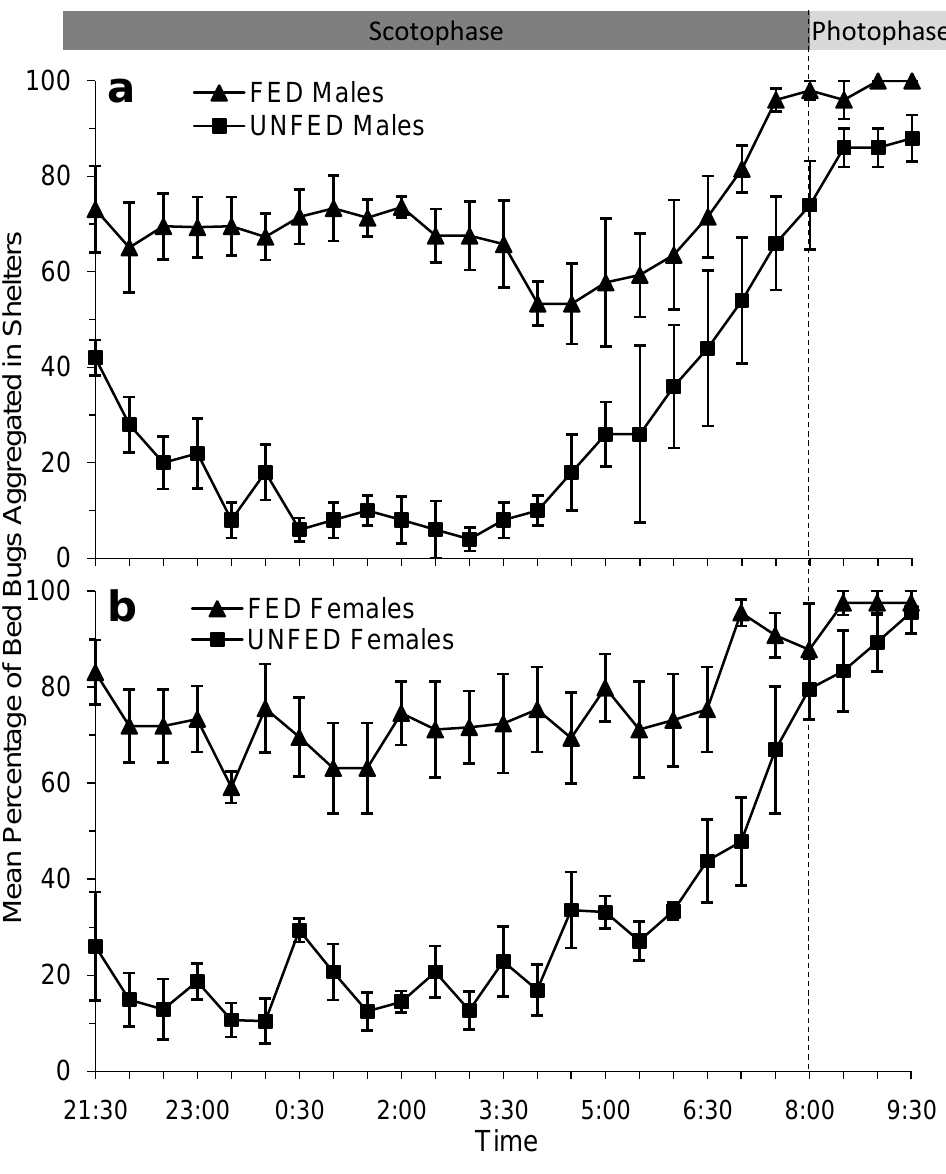
Figure 2. Mean percent of fed and unfed male ( a ) and female ( b ) bed bugs (± SE) inside shelters after being stimulated to forage by an artificial feeder for 30 min at 21:00 ( n = 5). Figure shows untransformed